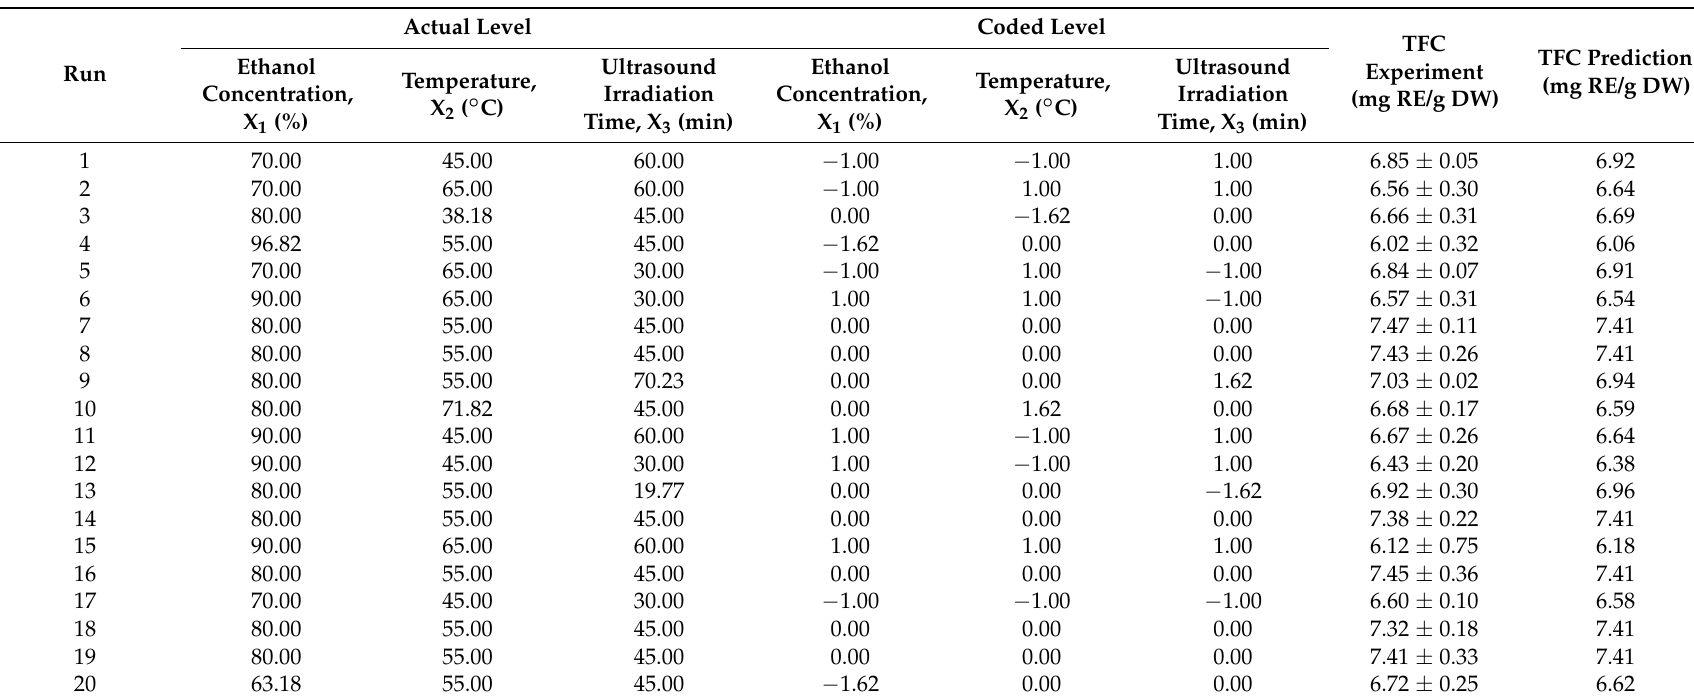
Table 2. Central composite design of ethanol concentration, temperature, ultrasound irradiation time, and their observed responses using UAE. DW—dried weight; TFC—total flavonoid